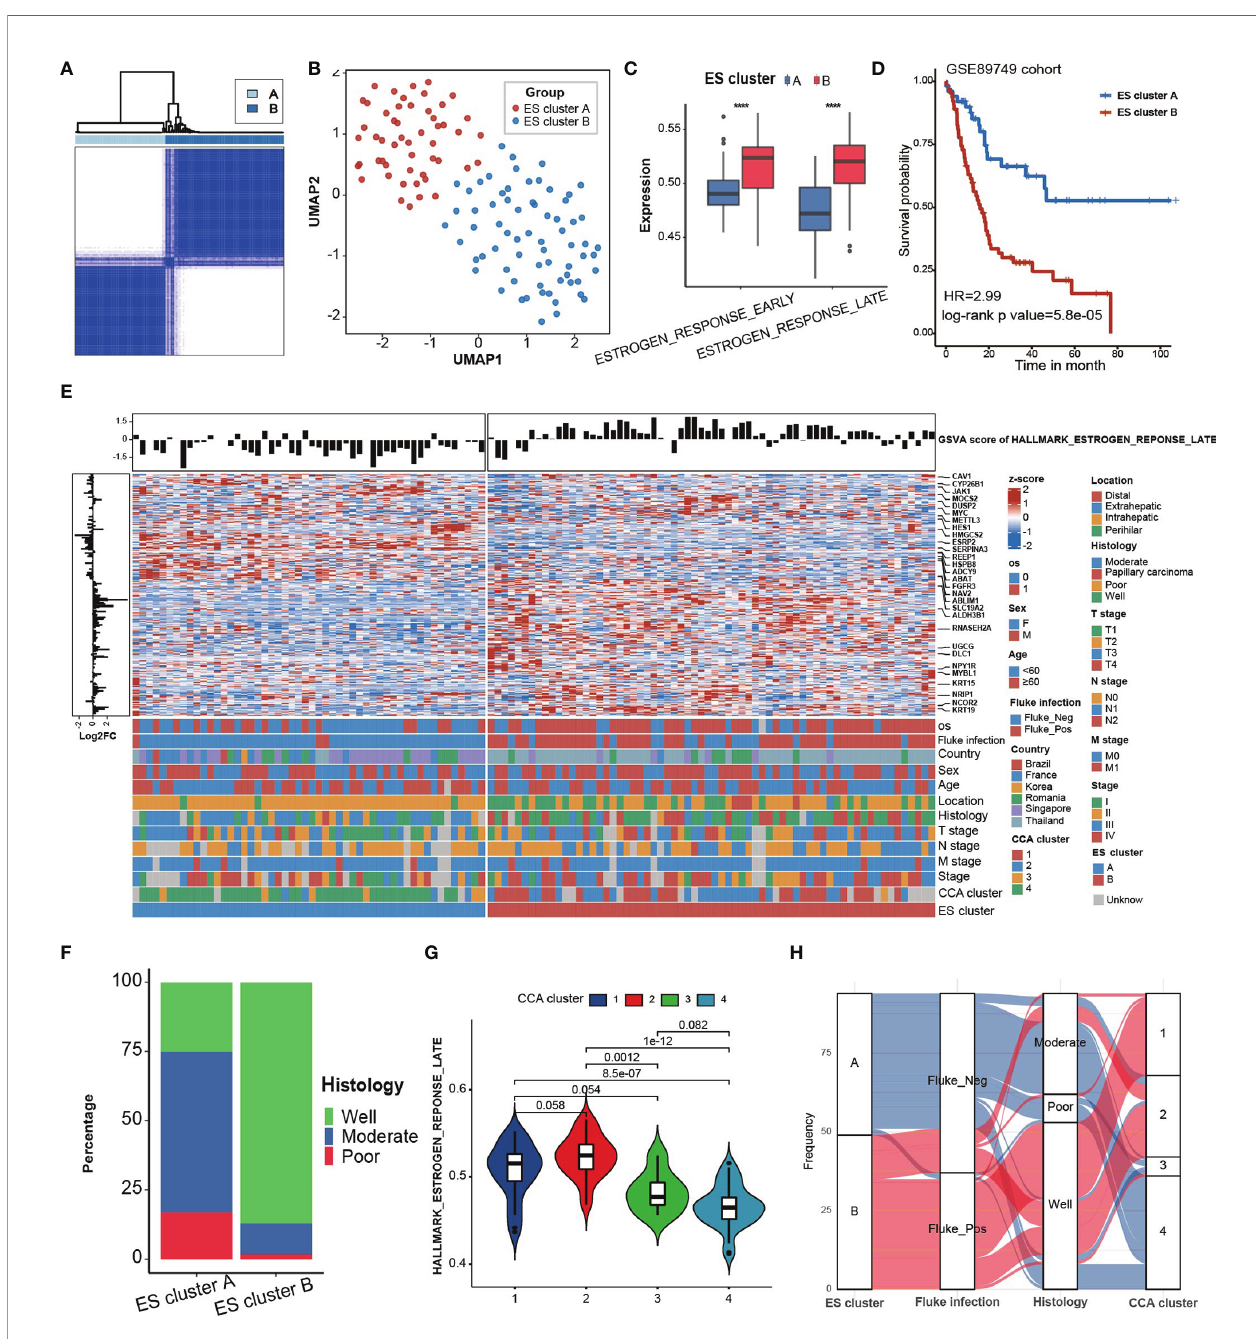
FIGURE 2 | Clinical characteristics of ES clusters in the GSE89749 cohort. (A) Consensus matrixes of the GSE89749 cohort based on the expression of genes in the green module. K=2 was chosen as optimal clustering by delta area. (B) A UMAP plot of 118 patients by dimensionality reduction of genes in the blue module showing 2 distinct ES clusters. (C) ES cluster B exhibited signi fi cantly higher GSVA scores for “ estrogen response late ” and “ estrogen response early ” than ES cluster (A, D) Kaplan – Meier curves for overall survival of the patients in ES cluster A and ES cluster B in the GSE89749 cohort. ES cluster A, n = 51; Score_high, n = 64. HR = 2.99, Log-rank test, p value = 5.8×10 -5 . (E) Heatmap showing the expression of 198 genes involved in “ estrogen response late ” in 118 CCA patients in the GSE89749 cohort. Clinical information, including overall survival status, sex, age, fl uke infection status, country, CCA clusters, location, histology, T stage, N stage, M stage, clinical stage, and ES clusters, is shown as patient annotation. The GSVA score of “ Estrogen response early ” of each patient was annotated on the top of the heatmap. The log2FoldChange of each gene between ES cluster A and ES cluster B is annotated on the left of the heatmap. (F) Stacked bar chart showing the proportion of different histological classi fi cations in the ES cluster A and B groups in the GSE89749 cohort. (G) Violin plot showing the GSVA score of “ Estrogen response early ” in four subtypes of CCA clusters. (H) Alluvial diagram showing the relation among different ES clusters, fl uke infection status, histology and CCA clusters. Statistical p-value ( ****,P <